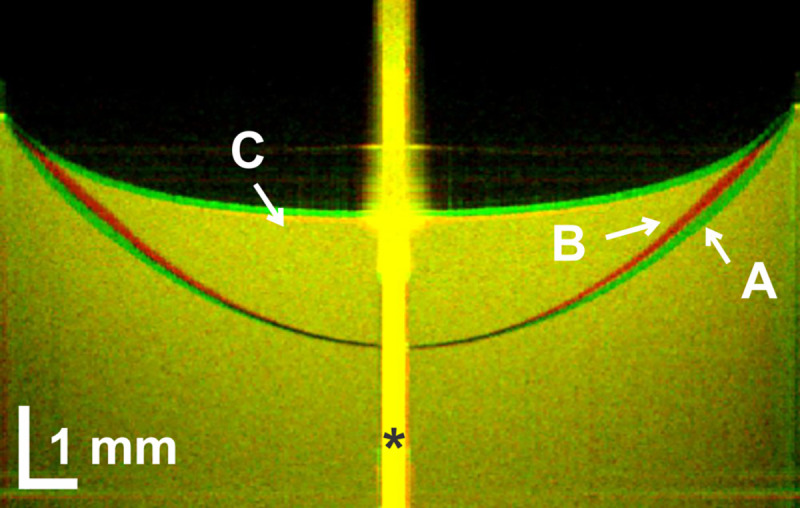
Superimposed cross-sectional SS-OCT images of a -3.00 D soft SiH SCL in a wet cell filled with solution of increased reflectivity.A—new lens, immediately after removal from the blister pack (green); B—used lens, immediately after removal from the eye after 7-day continuous wear (red); C—Meniscus of the solution of increased reflectivity. *artefact of the central light reflex.